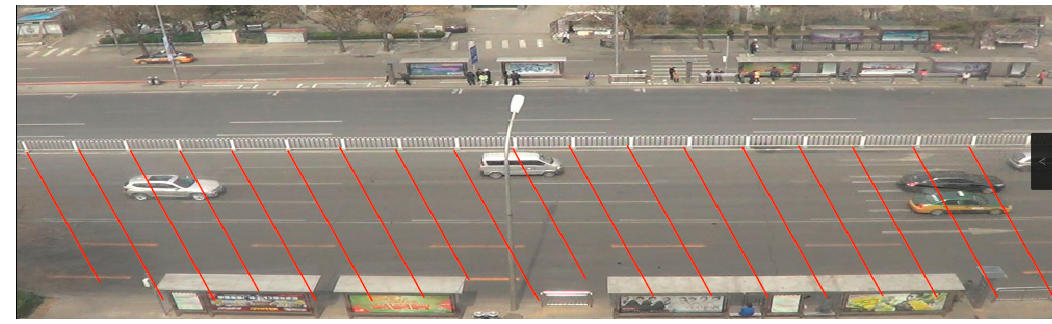
Figure 4. Skeleton map of detection line configuration.